Question: What kind of plot is shown here?
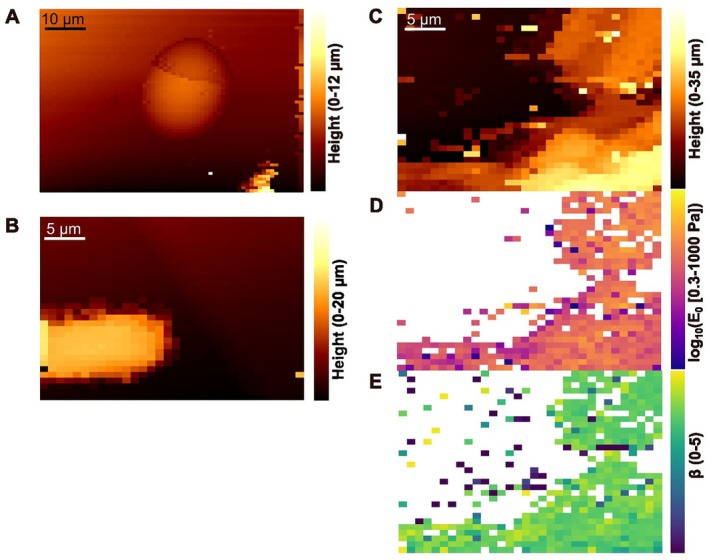
Answer: line